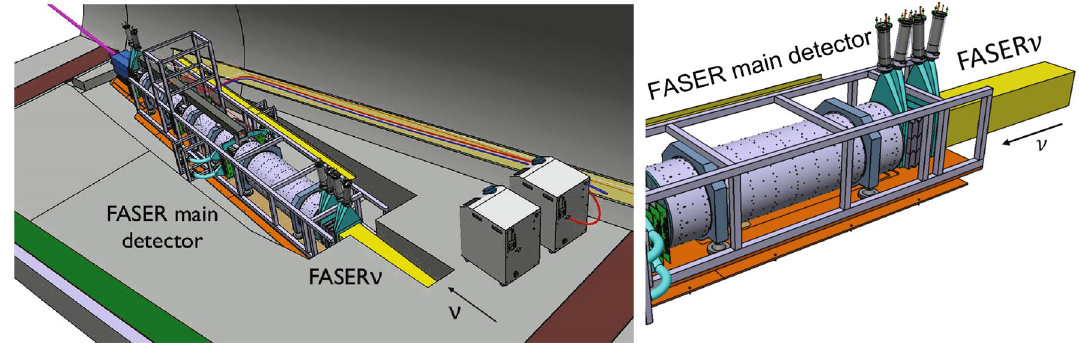
Fig. 2 View of FASER, including the FASER ν detector, in tunnel TI12, 480 m downstream from the ATLAS IP along the beam colli- sion axis. The FASER ν detector is a 25cm × 25cm × 1 . 35m emulsion